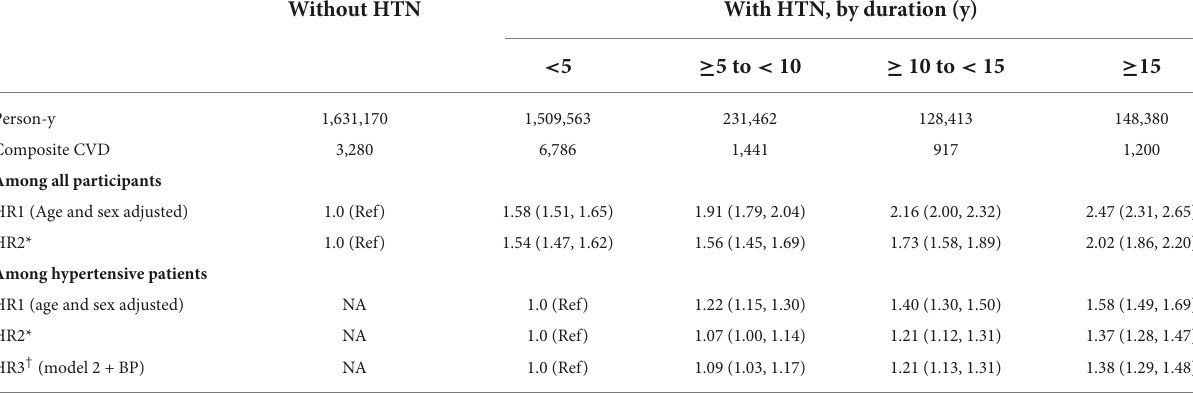
TABLE 2 Hazard ratios and 95% confidence intervals for the associations between hypertension duration and risk of composite cardiovascular disease. Without HTN With HTN, by duration